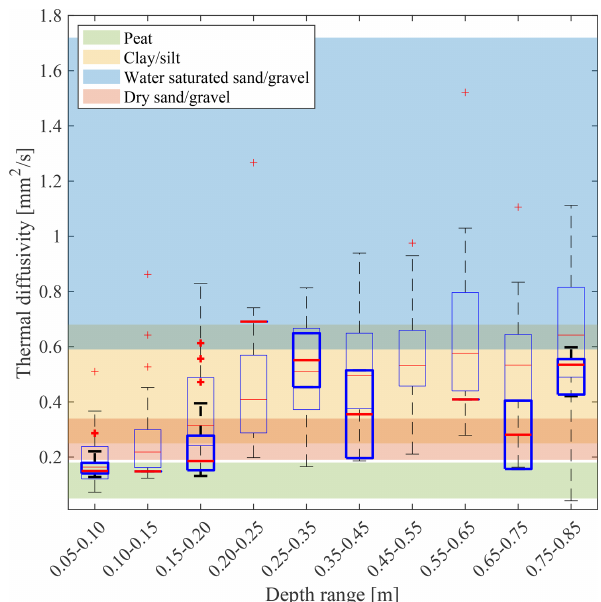
Figure 6. Boxplots at soil depth ranges of the measured thermal diffusivity (bold boxes) from 92 soil samples and of the thermal diffusivity values (thin boxes) inferred from MCMC inversions at 27 locations. The colored shaded areas indicate the range of ther- mal diffusivity values that characterized different soil types (Andú- jar Márquez et al.,